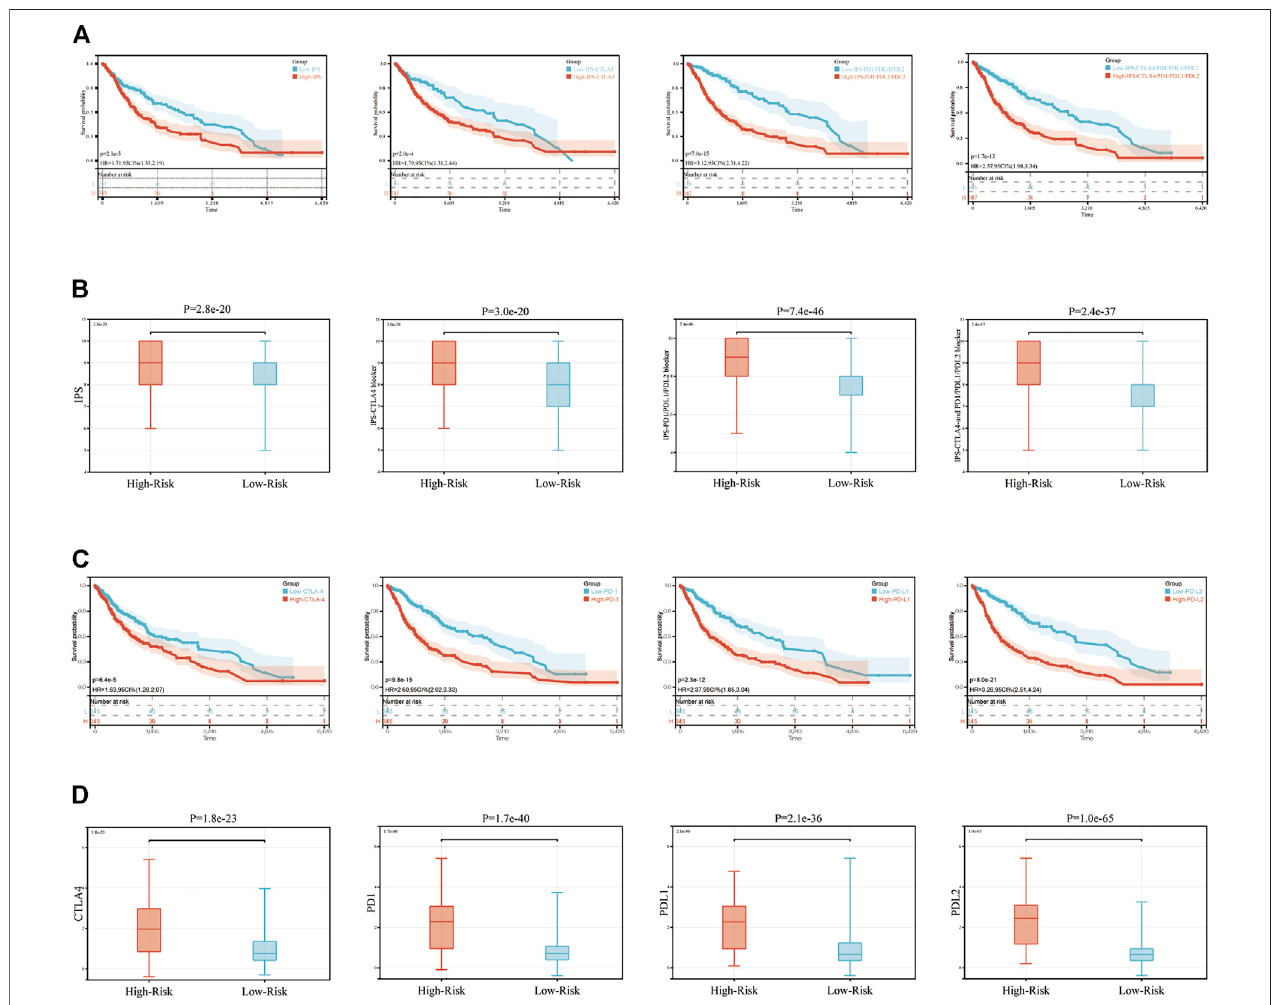
FIGURE 7 | IPS and immunotherapy gene expression analysis. (A) The association between OS and IPS, IPS-CTLA4 blocker, IPS-PD1PDL1PDL2 blocker, IPS- CTLA4-and PD1PDL1PDL2 blocker. (B) The association between IPS and immune-related signature in patients with glioma. (C) The association between OS and CTLA4, PD1, PDL1, PDL2. (D) The gene expression of PD1, CTLA4, PD-L1, and PD-L2 in low-risk and high-risk groups. IPS,